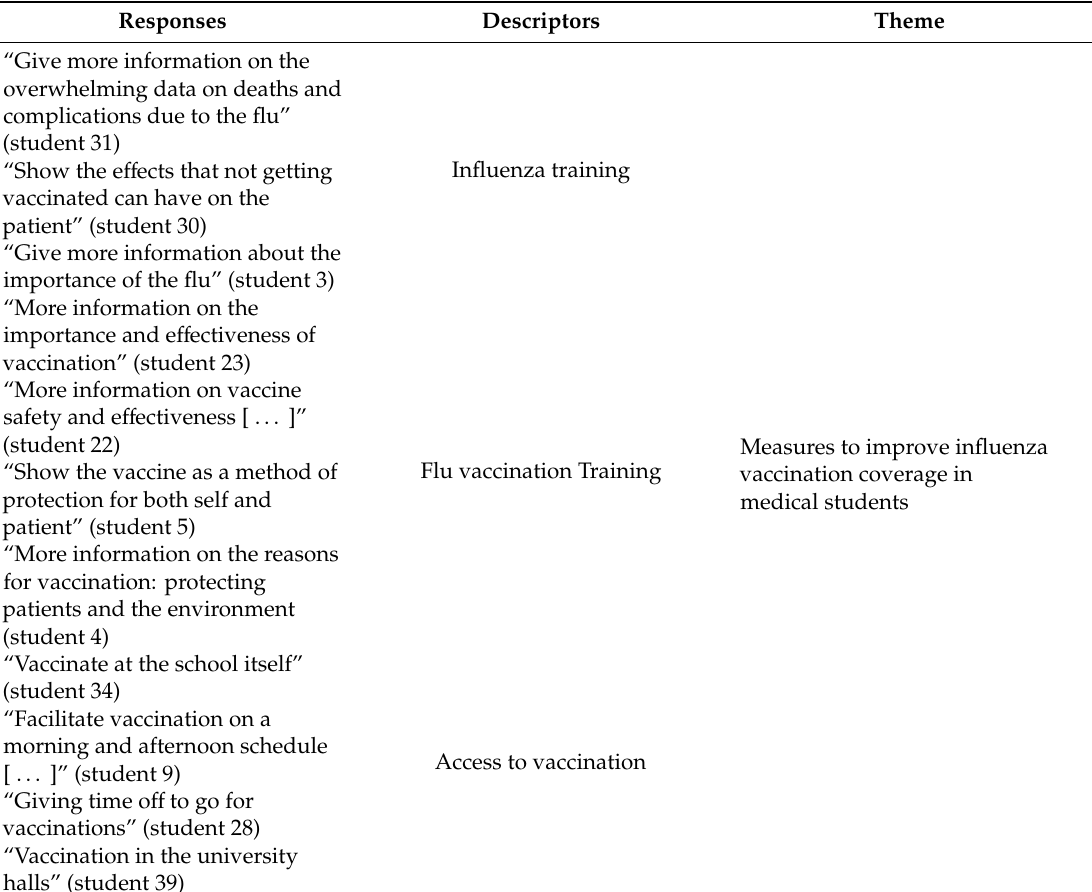
Table 1. Description of measures to improve vaccination coverage in medical